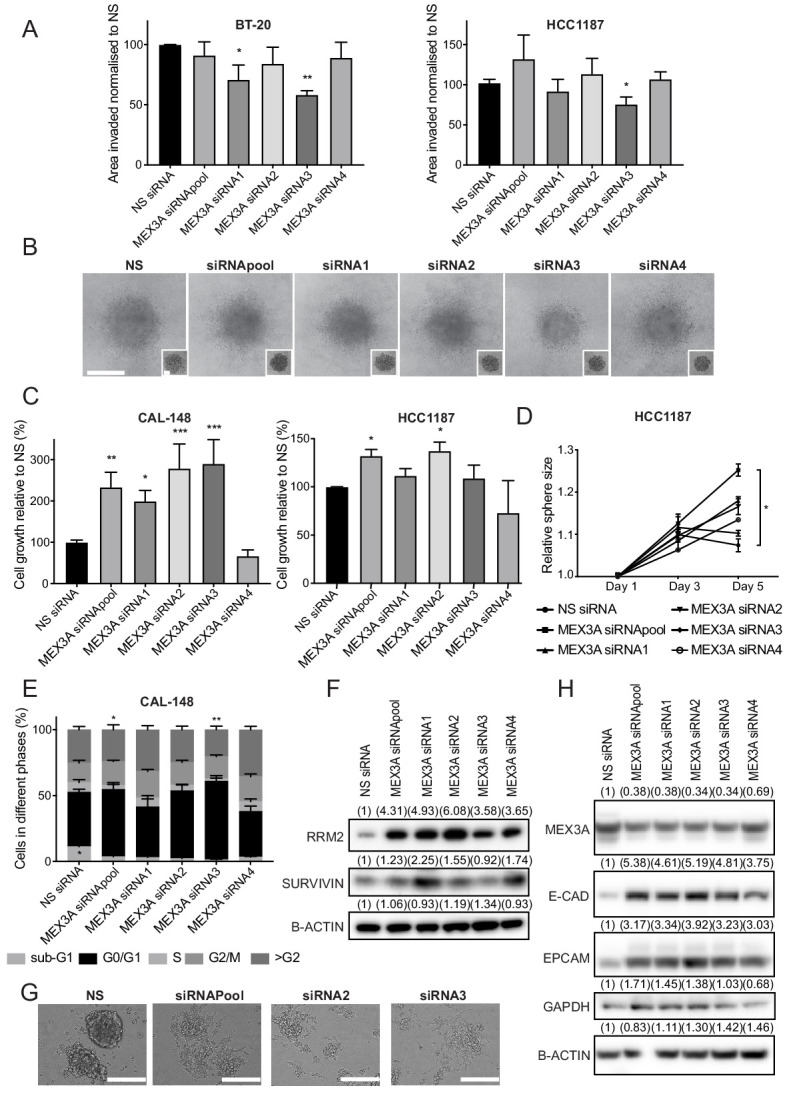
MEX3A, a novel SOX11 downstream effector, regulates cell growth and (E/M) state of ER- breast cancer cells.(A) Invasion assay results after overlaying BT-20 and HCC1187 spheroids with Collagen I, at day two after siRNA transfection specific for MEX3A or control (NS). Graph shows the area invaded in pixel2 normalised against NS siRNA. *p = 0.0181, **p = 0.0014 for BT-20 and *p = 0.0220 for HCC1187 cells. (B) Representative images of BT-20 spheroids 48 hr after adding Collagen I and at time 0 hr (shown in small inset, 2 days after transfection) made from cells transfected with either control siRNA or MEX3A siRNAs. Scale bar: 200 μm. (C) Cell growth assays 5 days after CAL-148 and HCC1187 cells were transfected with siRNA specific for MEX3A or NS controls (siRNAs require 48 hr for efficient knockdown; this was taken into account to select day five as final point). Relative results to NS siRNA are shown. Experiments performed three times. *p = 0.0342, **p = 0.0052 ***p = 0.0005 (siRNA2), ****p < 0.0003 (siRNA3) for CAL-148 cells and *p=0.0337 (siRNApool) and *p = 0.0477 for HCC1187 cells. (D) Sphere size measured 3, and 5 days after HCC1187 cells were transfected with siRNA specific for MEX3A. Relative results to NS siRNA are shown. Experiments performed three times *p = 0.0240. (E) Cell cycle analysis performed by flow cytometry at day 4 after siRNA transfection specific for MEX3A in CAL-148 cells. Graph shows % of cell in each phase of the cell cycle. *p = 0.0147 (phase S siRNApool vs siRNA NS) and *p = 0.0094 (phase S siRNA3 vs siRNA NS) and *p = 0.0419 (phase subG1 NS vs siRNA3). Experiments performed four times. (F) Western blot of RRM2 and SURVIVIN in total cell lysates of CAL-148 at day four after siRNA transfection specific for MEX3A. β-ACTIN was used as loading control. Densitometry results normalised against NS siRNA are shown in brackets. (G) Examples of morphological changes observed in CAL-148 cells after 4 days of MEX3A knockdown compared to NS control. Scale bar: 200 μm. (H) Western Blot of EPCAM and E-CADHERIN in CAL-148 cells transfected with siRNA specific for MEX3A or NS control. β-ACTIN was used as loading control. Densitometry results normalised against NS siRNA are in brackets. NS: non-silencing.